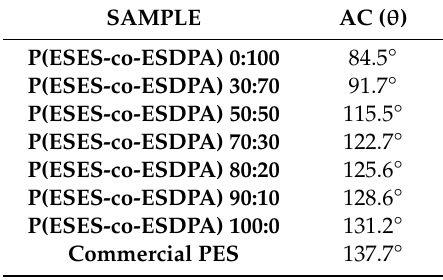
Table 4. Contact Angle values of the P(ESES-co-ESDPA) polymers and the commercial PES sample.